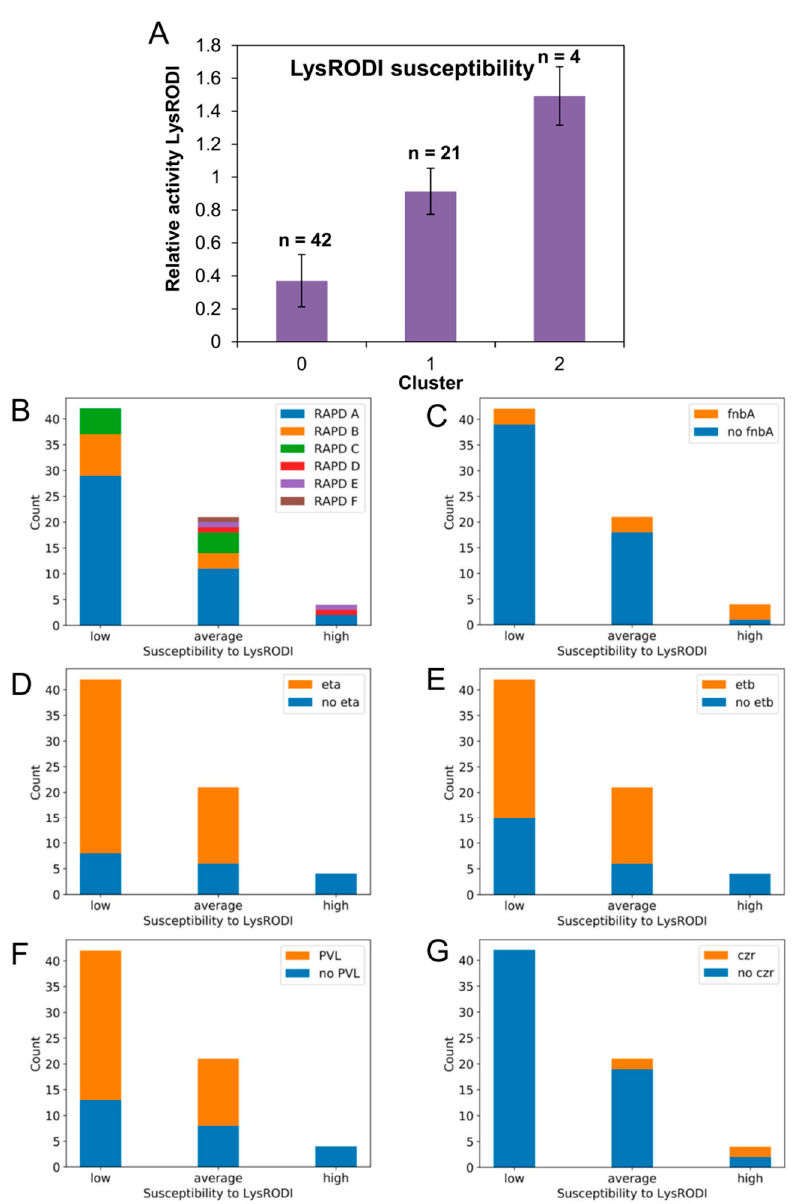
Figure 5. Susceptibility of the clinical MRSA isolates to endolysin LysRODI. ( A ) Clustering of MRSA isolates based on their susceptibility to LysRODI into strains with low (cluster 0), average (cluster 1) and high (cluster 2) susceptibility compared to reference strain Sa9. The graph represents the means ± standard deviations for the values of each group, while also indicating the number of strains that belongs to each cluster. ( B – G ) Stacked bar charts representing the number of strains belonging to each cluster that have a different RAPD pattern or carry genes fnbA , eta , etb , PVL and czr .